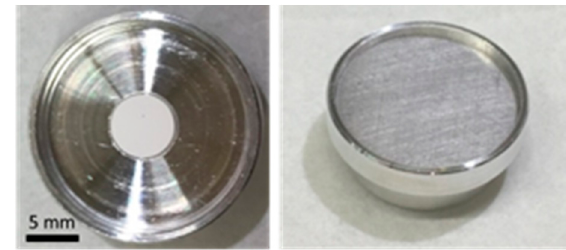
Figure 2. Pressed CaO target (6 mm × 0.5 mm) nestled in the indentation of an Al (99.5% pure) capsule. The capsule was sealed and prepared for irradiation at PSI’s IP2 irradiation station.